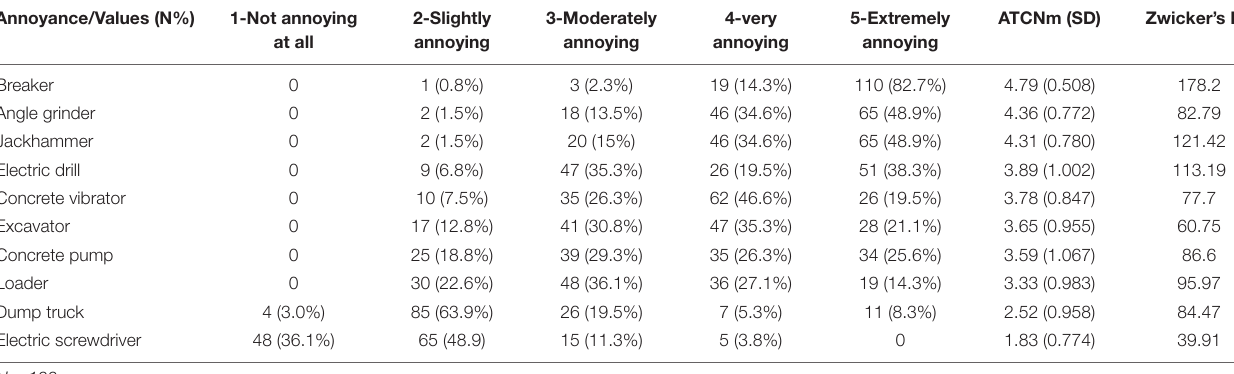
TABLE 7 | Results of typical noise-induced annoyance.